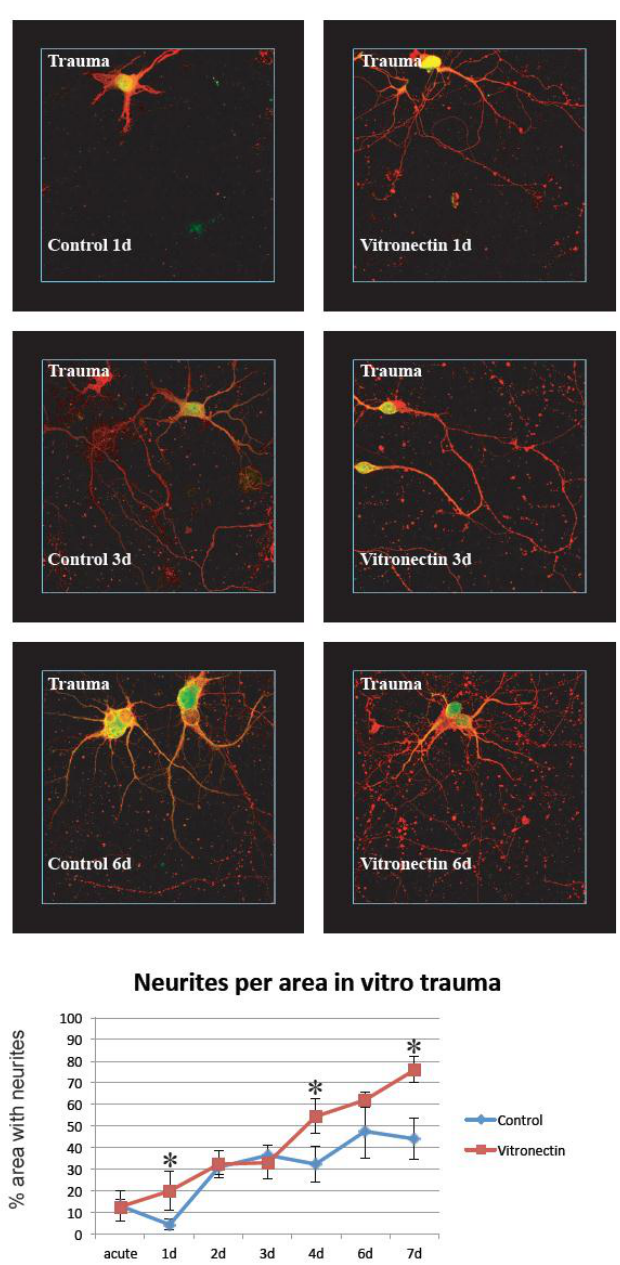
Figure 4. After in vitro trauma to cultured hippocampal neurons, neurite extension was calculated at the border between viable cells and the central area of injury. Neurons regrew neurites slightly better on vitronectin than on the standard coating. At 1, 4, and 7 days after trauma, there were significantly (*) more neurites when neurons were grown on vitronectin compared to the control coating ( n = 6 (6 wells per time point and treatment), two-way ANOVA with Bonferroni post hoc test, p < 0.05) (red = beta III tubulin, green/yellow =